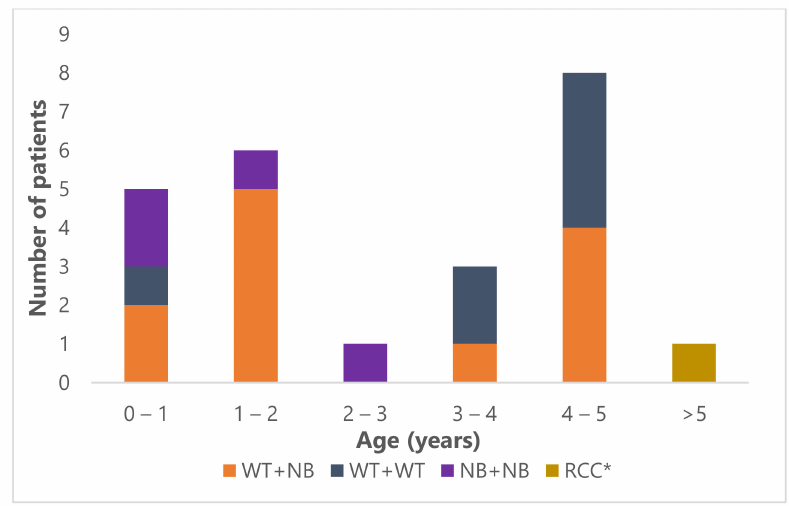
Figure 1. Age distribution of the 24 bilateral renal tumor patients. WT: Wilms tumor; NB: nephrob- lastomatosis; RCC: renal cell carcinoma; *: the patient with RCC was 15 years old at